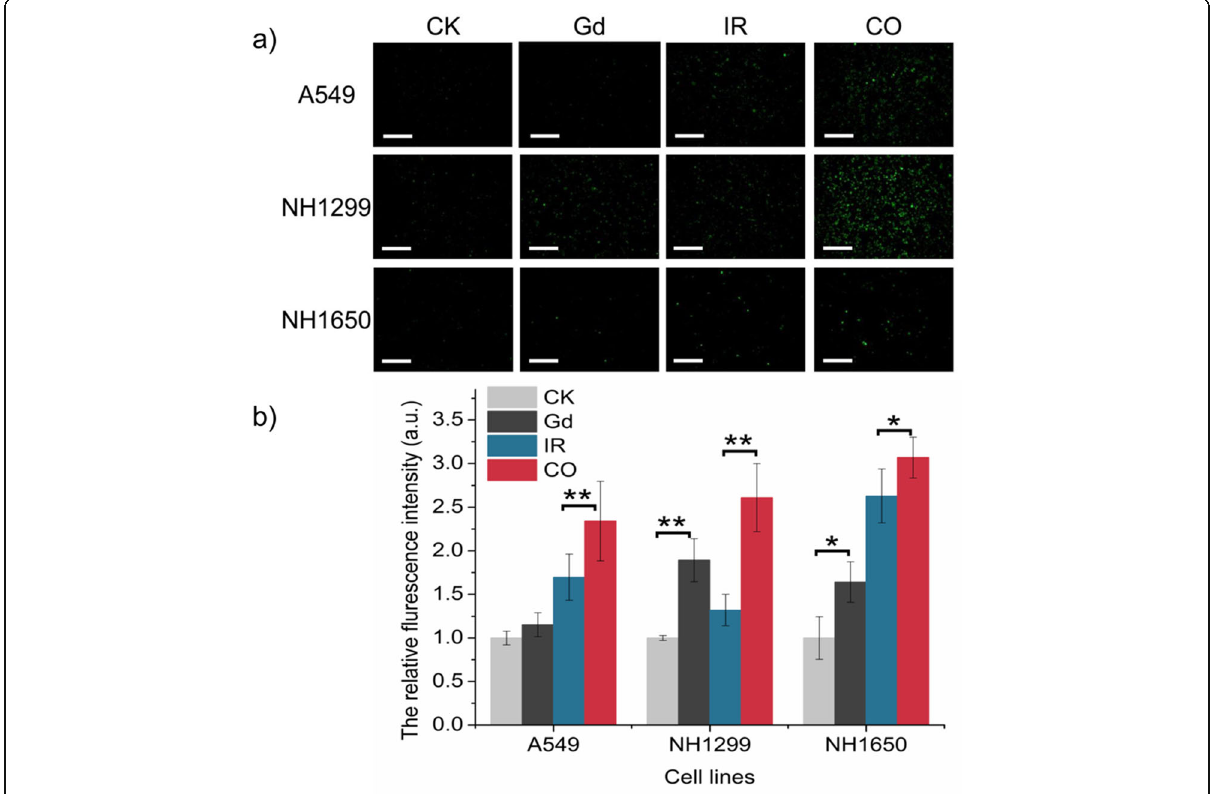
Fig. 3 GONs promoted ROS production. a The fluorescence images of ROS production observed after radiation by DCFH-DA, “ CO ” means the cotreatment with GONs and carbon ion radiation; scale bar represents 200 μ m. b The relative fluorescence intensity of cells with or without GONs was analyzed using ImageJ software. * p < 0.05 or ** p < 0.01 represent statistically significant or extremely significant differences,